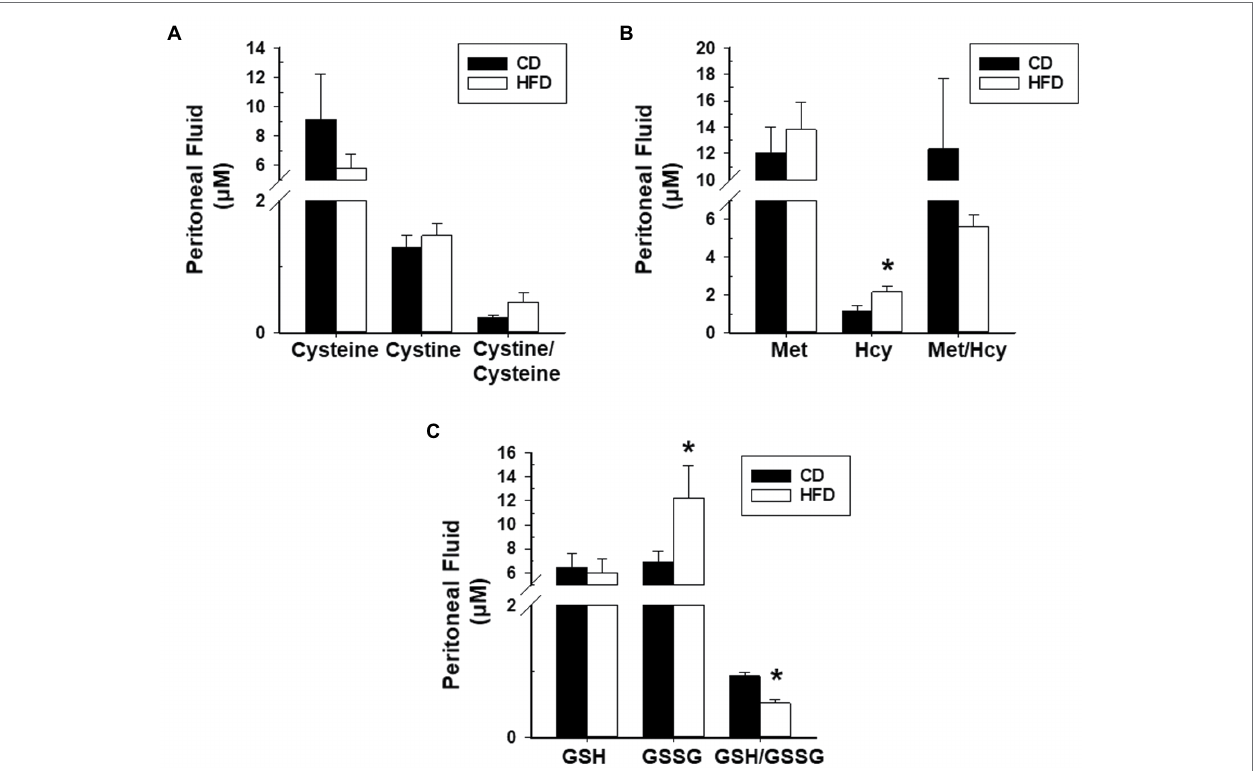
FIGURE 5 | HFD effects on levels of peritoneal fluid oxidants and anti-oxidants and their ratios in recipient mice with lesions. (A) Cysteine, Cystine, and Cystine/ Cysteine ratio; (B) Methionine, Homocysteine, and Methionine/Homocysteine ratio; and (C) Glutathione, Glutathione disulfide, and Glutathione/Glutathione disulfide ratio. Data (mean ± SEM) are from n = 7 (CD) and n = 6 (HFD) mice per diet group. * p < 0.05 by Student’s t-